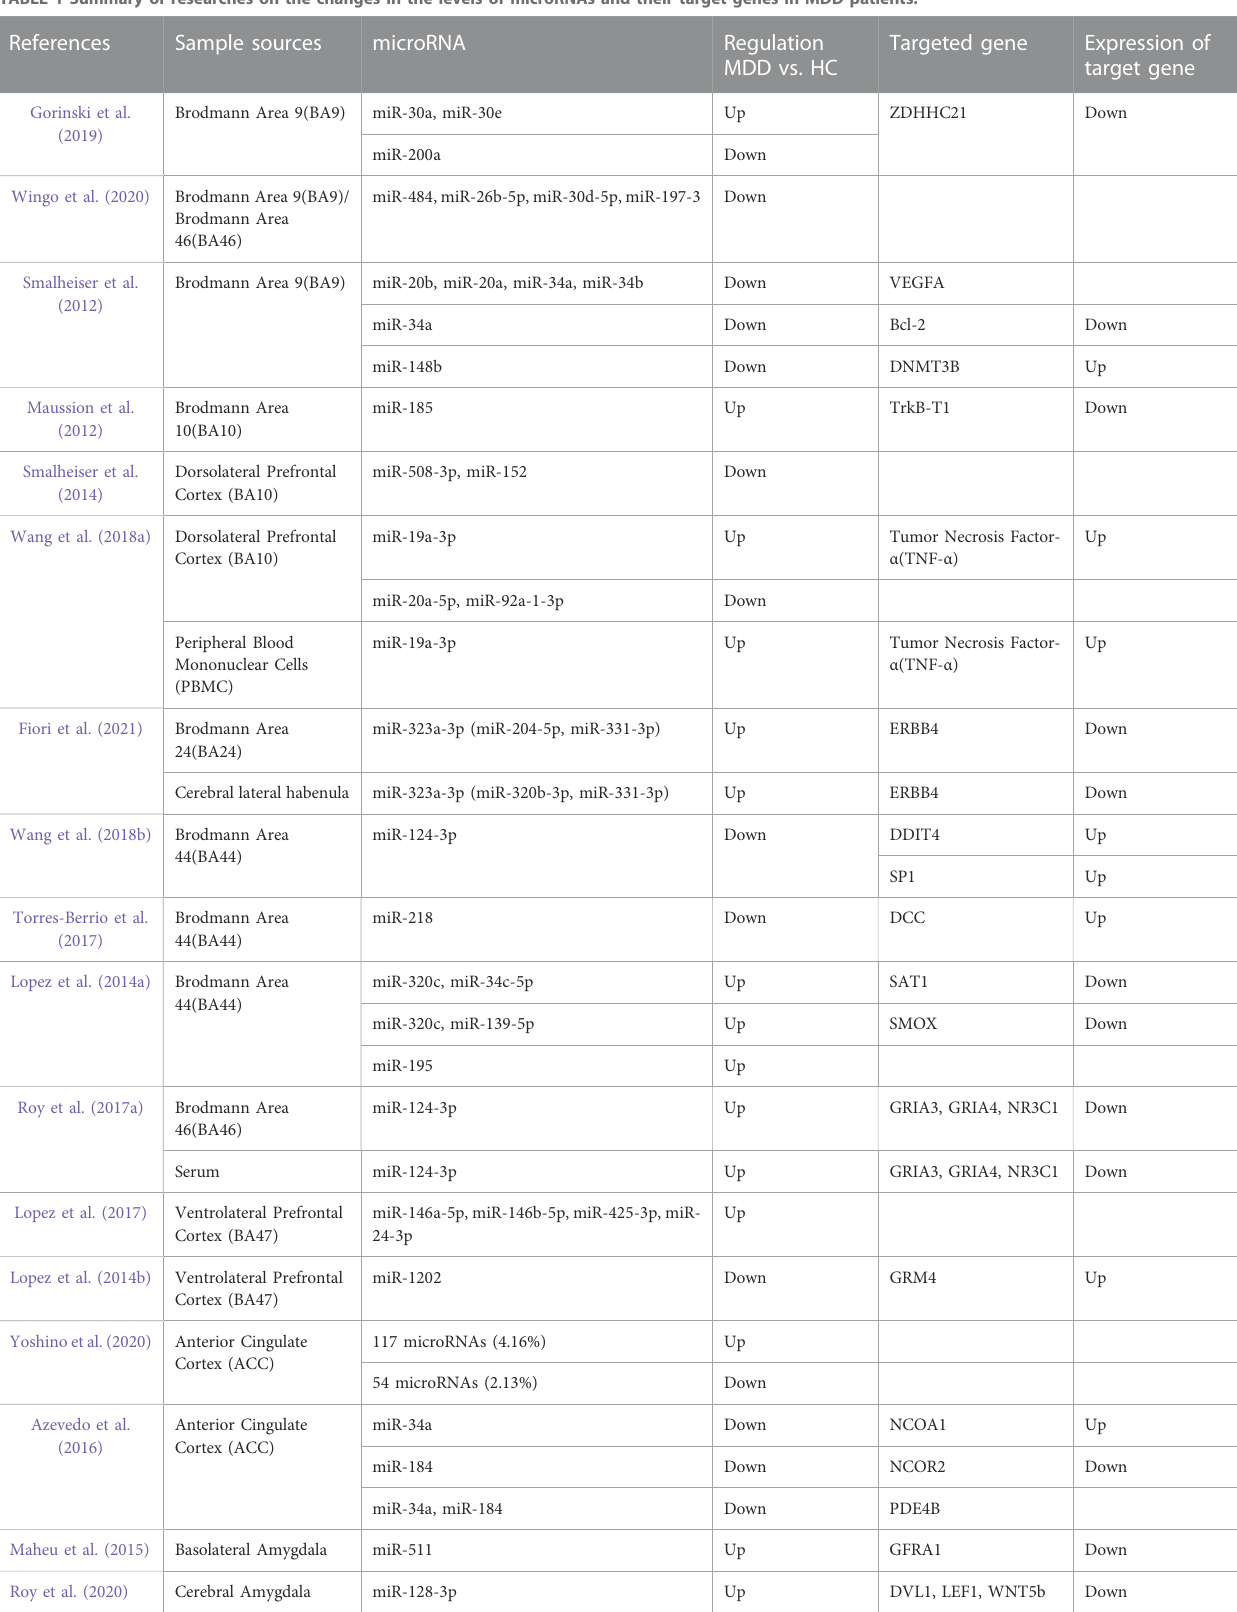
TABLE 1 Summary of researches on the changes in the levels of microRNAs and their target genes in MDD